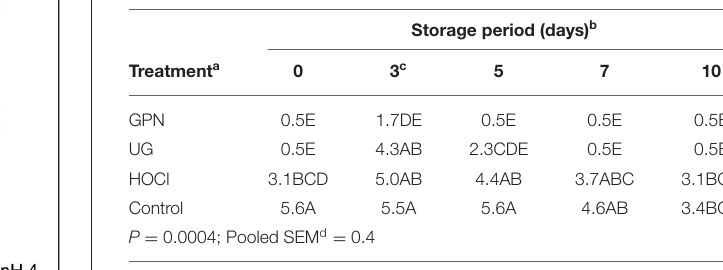
TABLE 1 | Least squares means of surviving Escherichia coli O157:H7 (log 10 CFU/cm 2 ) on spinach leaf surfaces by the interaction of antimicrobial treatment x storage